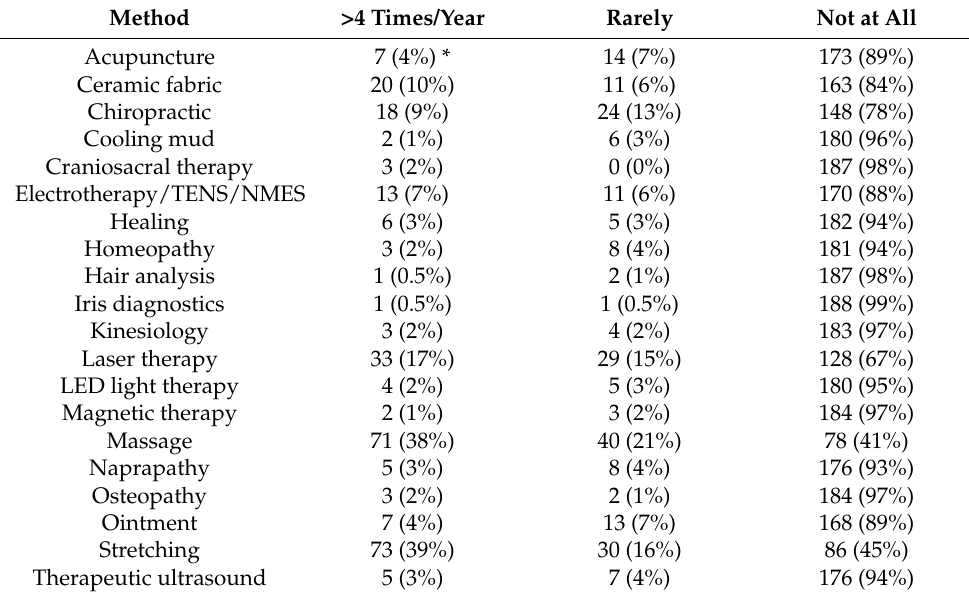
Table 1. Frequency of use of complementary and alternative veterinary medicine methods used for either therapy or prevention, as stated by Swedish dog owners responding to a questionnaire ( n ranging from 194 to